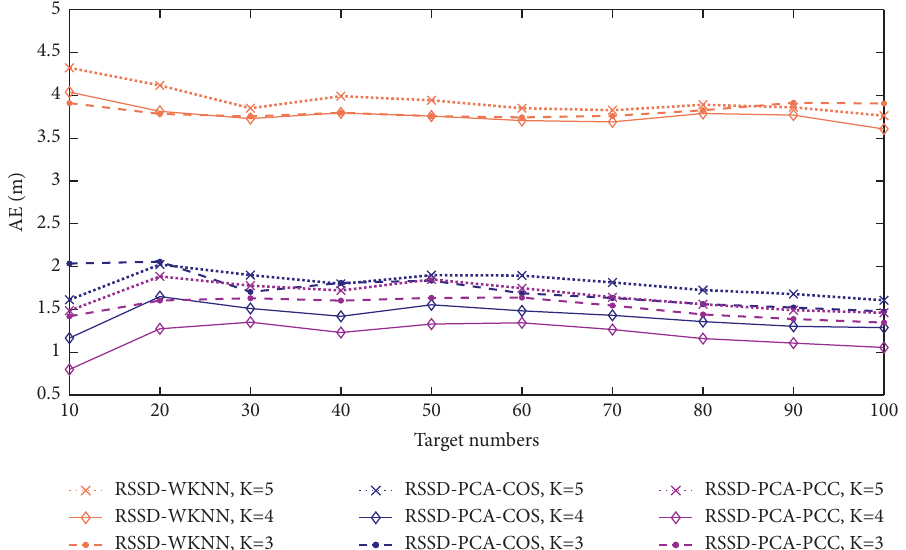
Figure 7: AE comparisons among RSSD-WKNN, RSSD-PCA-COS, and proposed RSSD-PCA-PCC when the number of positioning targets changes from 10 to 100 with 2 m grid distance and 4